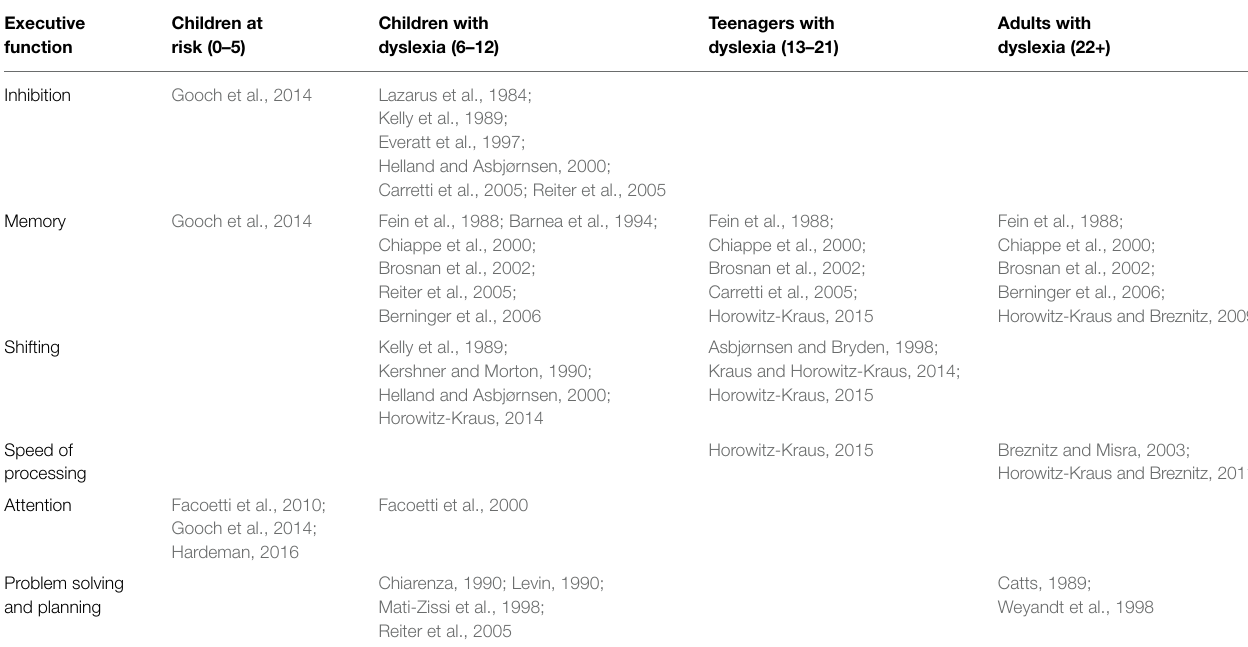
TABLE 1 | Executive dysfunctions in individuals with dyslexia along development. Executive